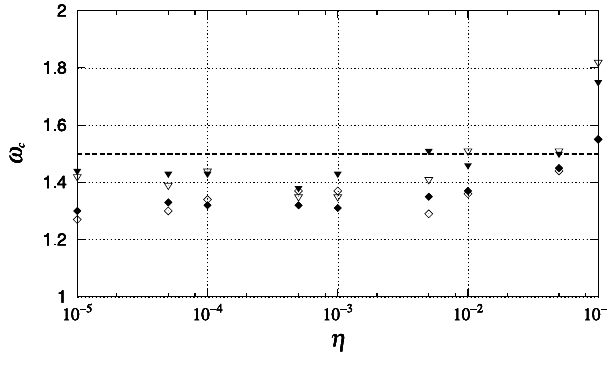
(cid:5) (cid:4) and are obtained when φ = 0 and